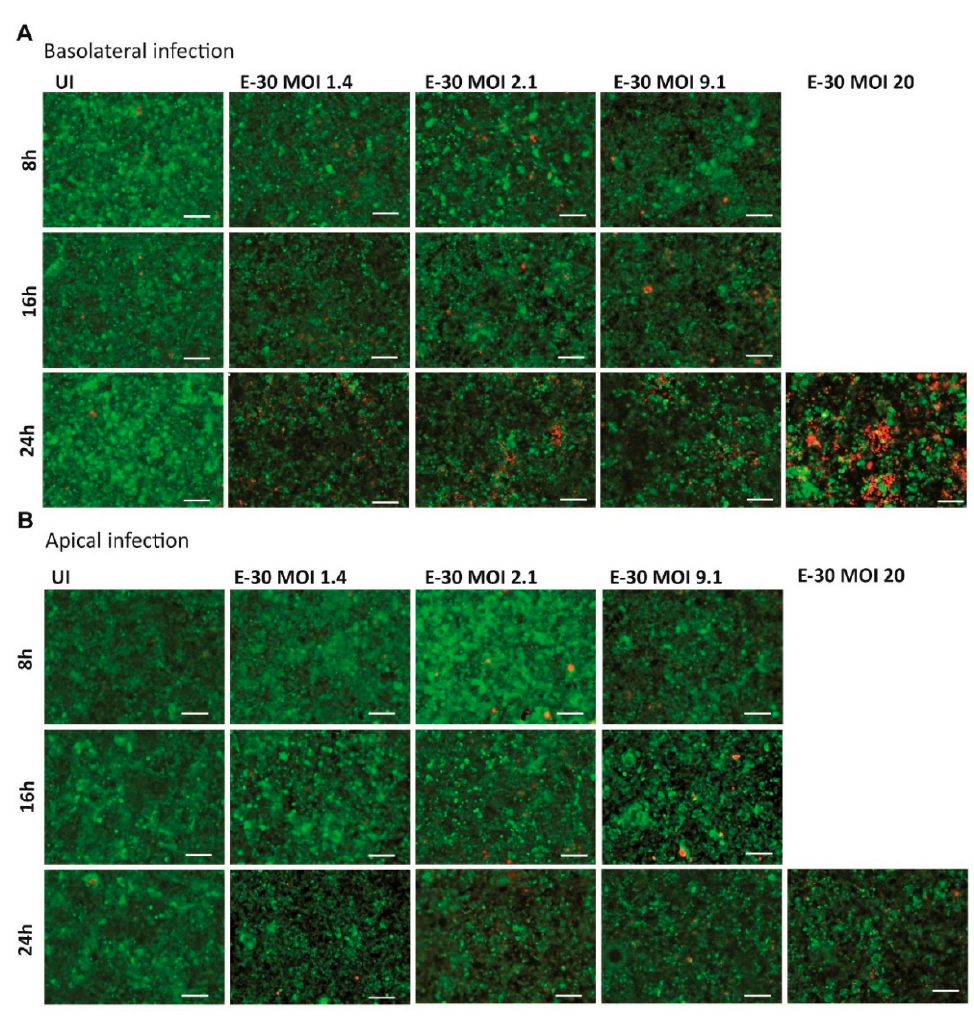
Figure 3. E-30 infection from the basolateral side of HIBCPP cells has a greater cytotoxic effect. The Live / Dead viability assay stained the living cells in green (cell tracker green) and the dead cells in red (ethidium homodimer-1). Images of HIBCPP cells infected from the basolateral side ( A ) and the apical side ( B ), for 8, 16 and 24 h and for each condition (uninfected (UI), and with E-30 infection at MOI 1.4, 2.1, 9.1 and 20). The pictures show representative images from three experiments, each performed in duplicates. White scale bars represent 100 µM.